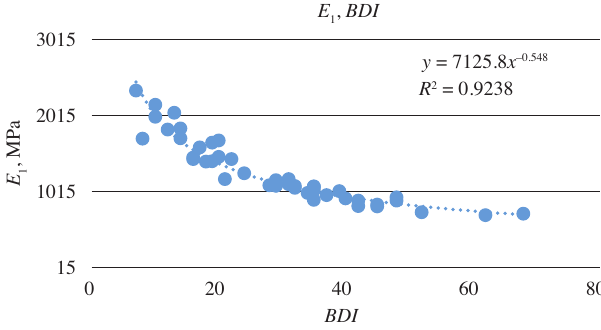
Figure 2. Relationship between BDI and back calculated from deflection d